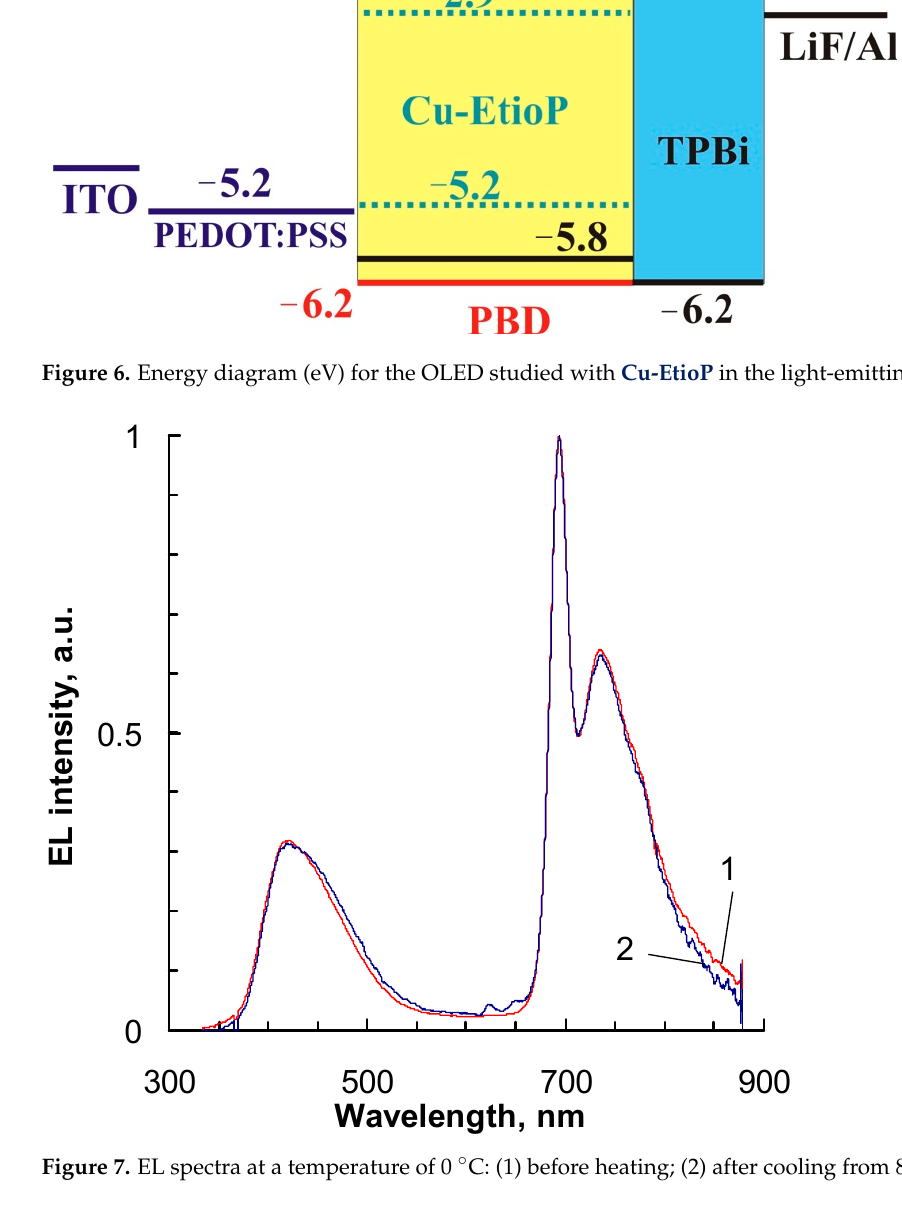
Wavelength, nm Figure 8. EL spectra of EL OLED with Cu-EtioP at − 195 °C (dark blue line) measured at an applied voltage of 14 V in Dewar of a Horiba Flurolog 3 instrument.